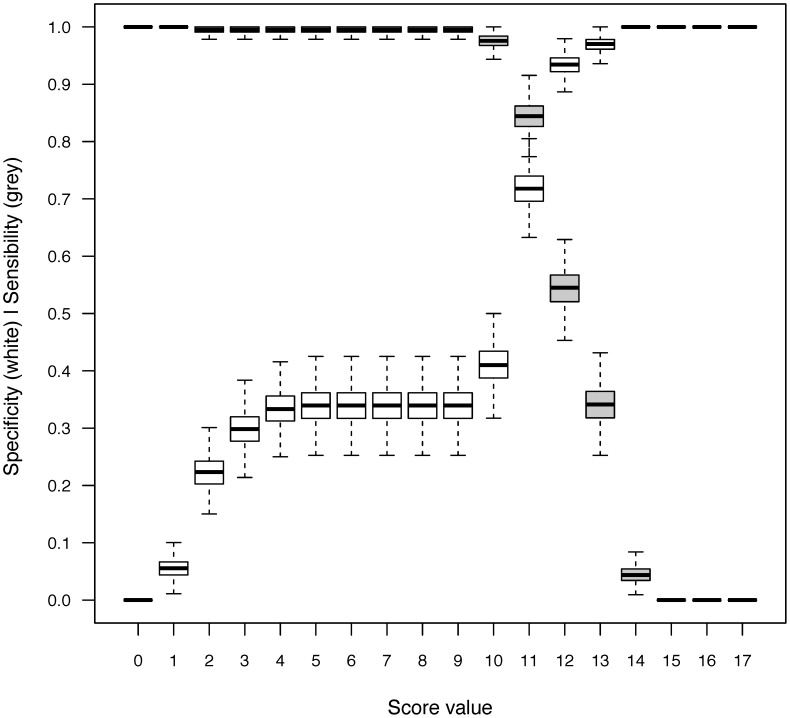
Sensitivity and specificity curves of the mixed clinical and biological malaria vs. dengue predictive score.